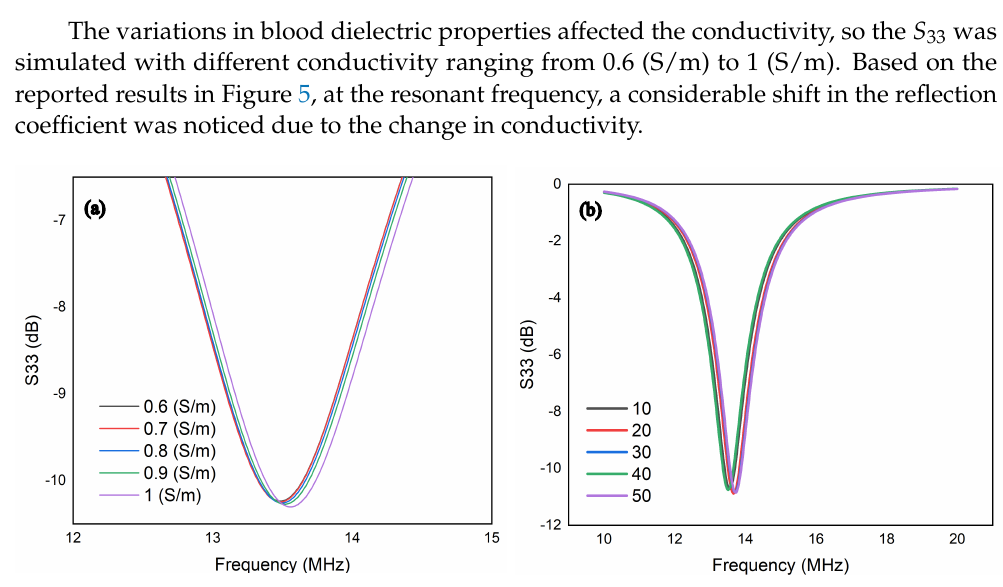
Figure 5. ( a ) S33 at different conductivities in the tissue medium under simulation; ( b ) S33 at varied distances in the tissue medium under